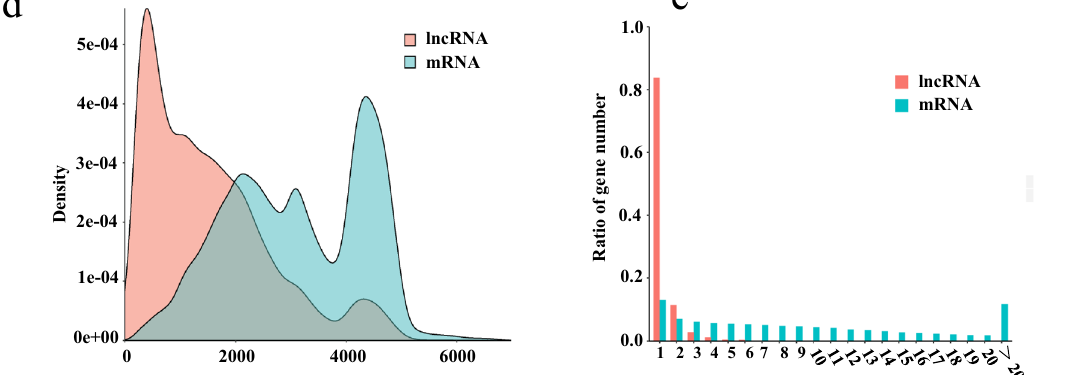
Figure 4. LncRNA identification and feature analysis. ( a ) The workflow of lncRNA identification. ( b ) The number of lncRNAs identified by CNCI, CPC, Pfam and PLEK methods. ( c ) The percentage of four classes of lncRNAs. ( d ) The comparison of transcript length distribution between lncRNA and mRNA. ( e ) The comparison of exon number between lncRNA and mRNA. The figures were constructed in ggplot2 (https :// ggplo t2.tidyv